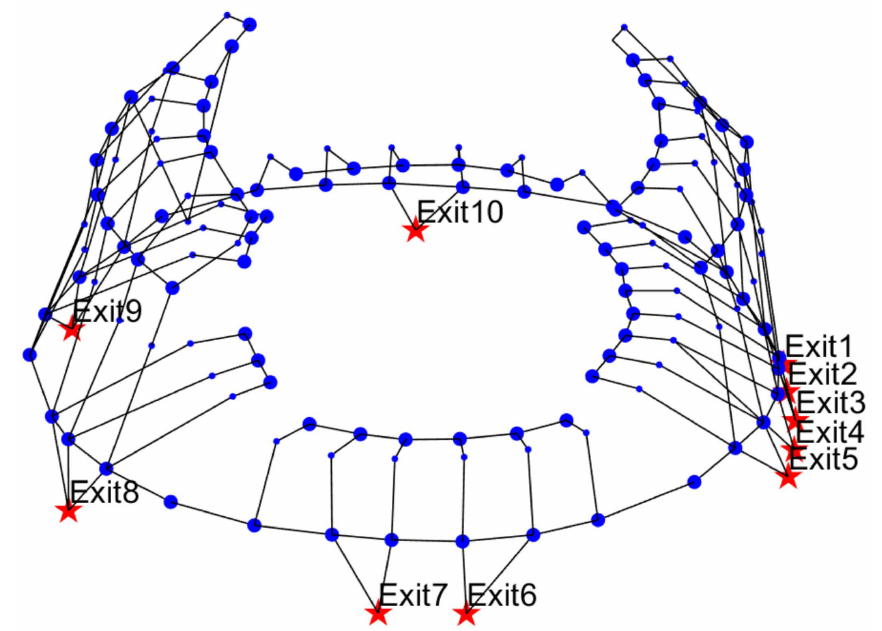
Figure 5. Evacuation network of study area.